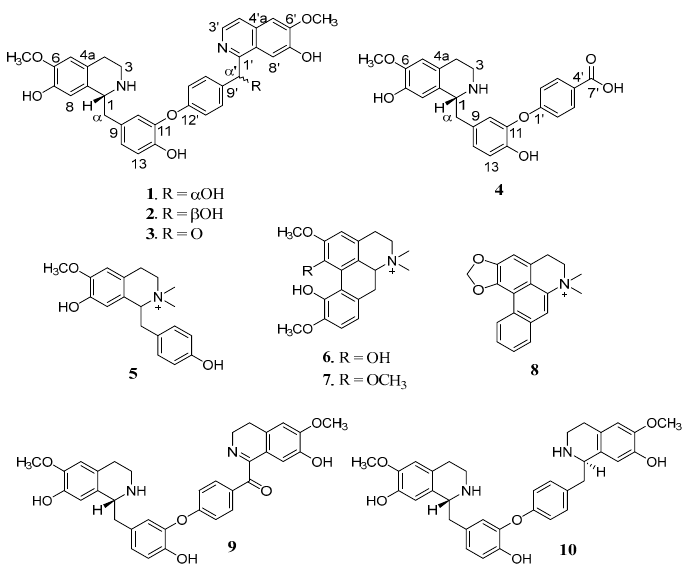
Figure 1. Chemical structures of isolated compounds 1 – 10 from L. scandens .